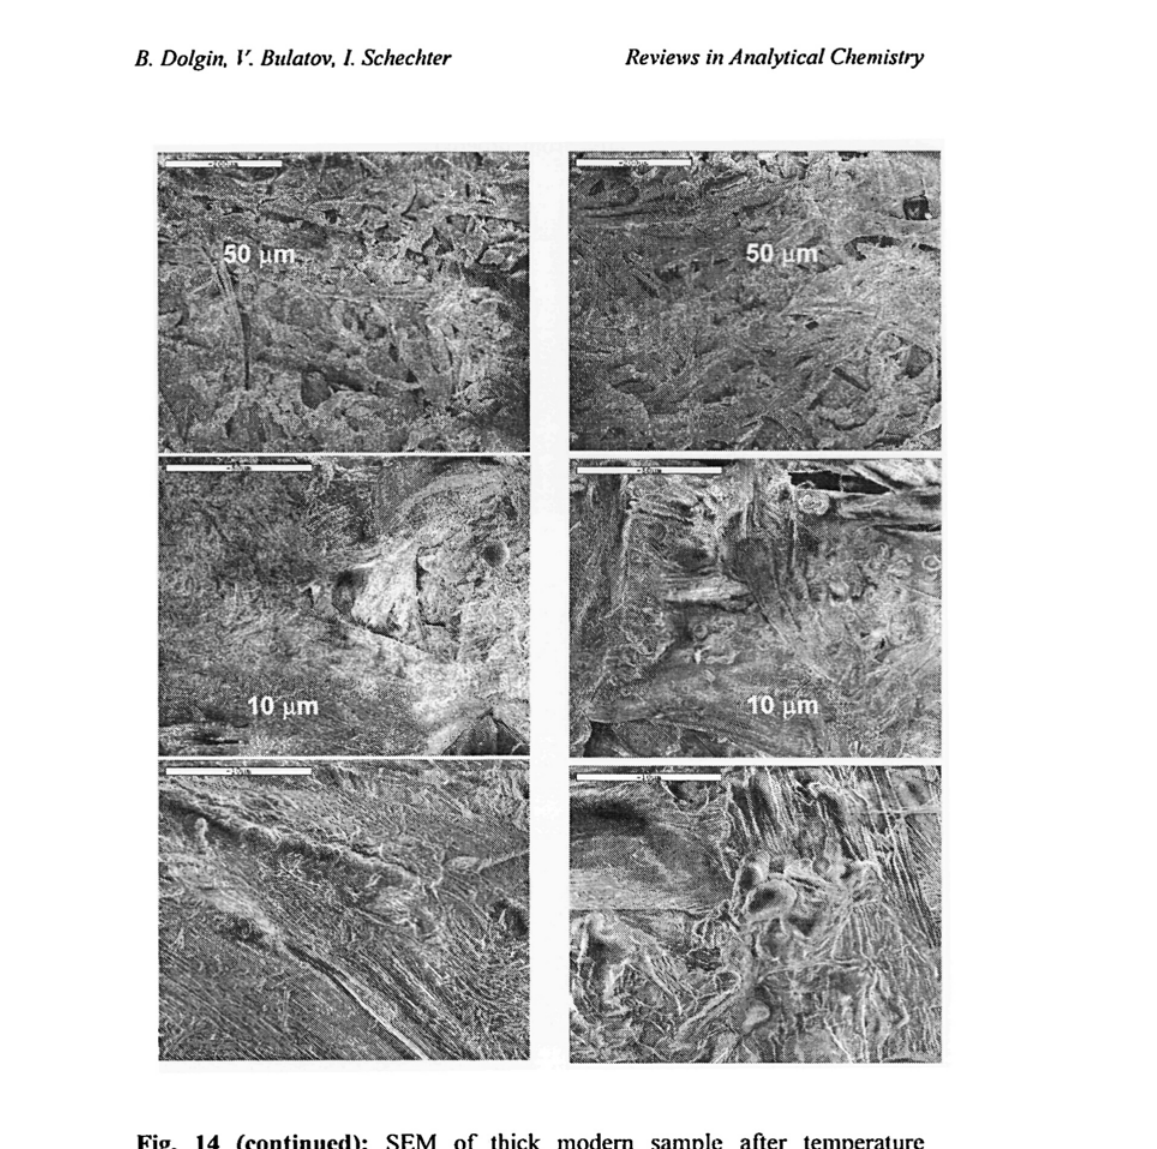
Fig. 14 (continued): SEM of thick modern sample after temperature treatment (left) and after moisture treatment